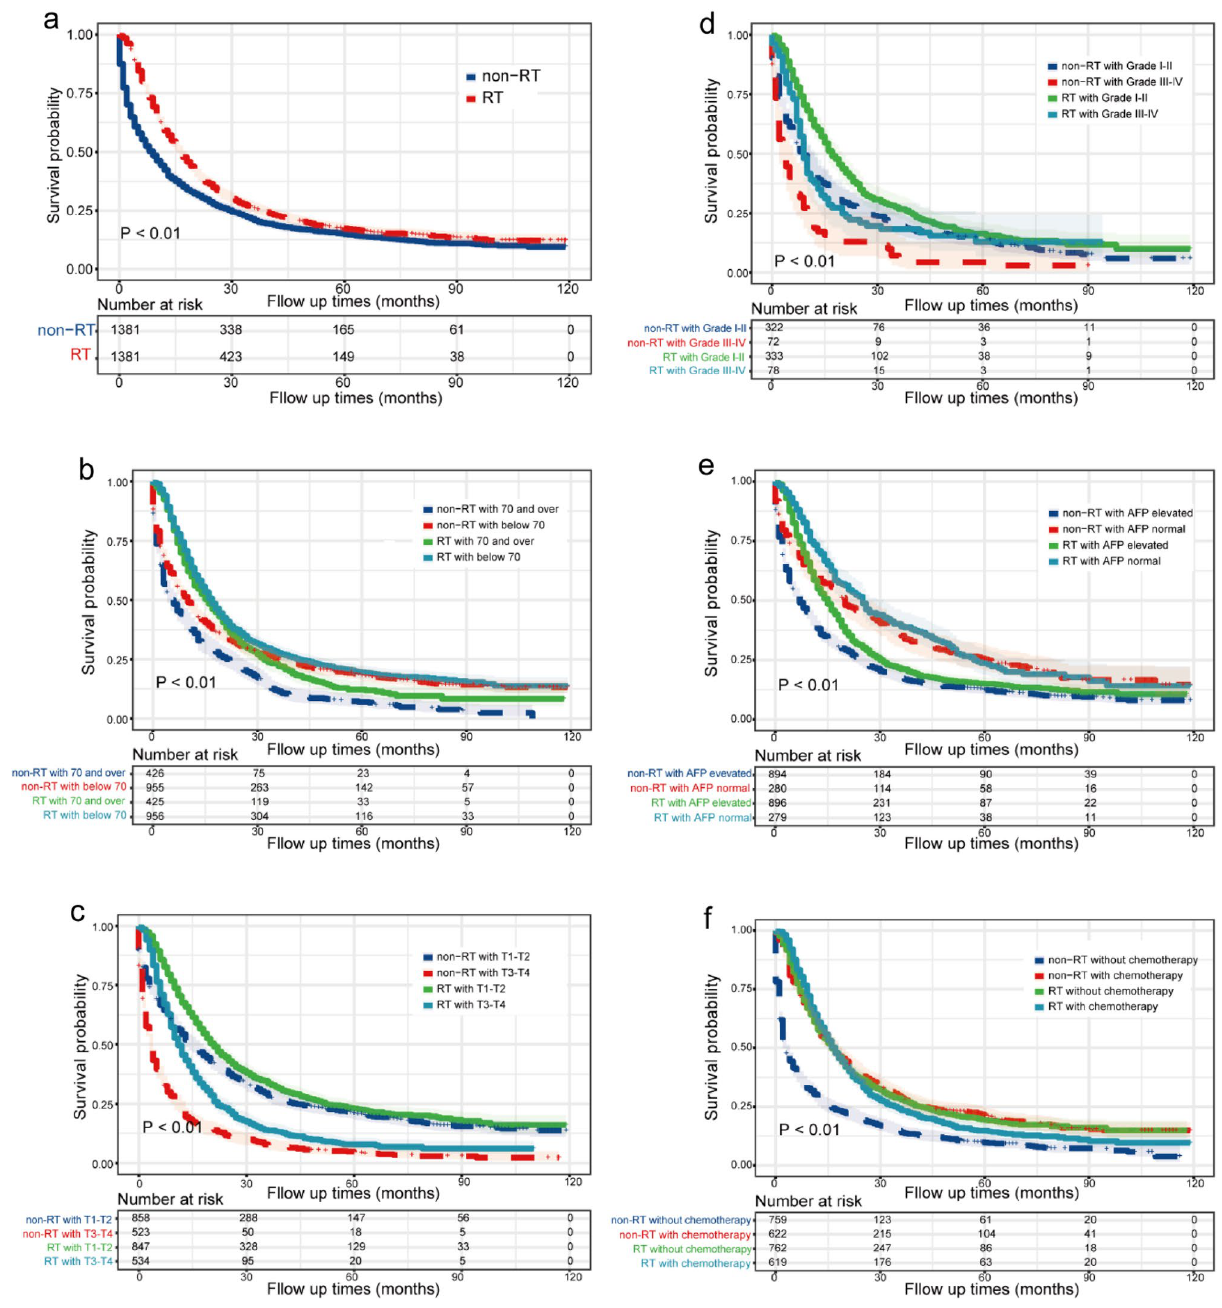
Figure 5. Kaplan–Meier overall survival (OS) estimates and 95% confidence intervals for patients in the RT and non-RT groups: ( a ) in the total sample and grouped by ( b ) age, ( c ) tumor (T) stage, ( d ) tumor differentiation grade, ( e ) serum AFP level, and ( f ) receipt of chemotherapy. RT radiotherapy, AFP